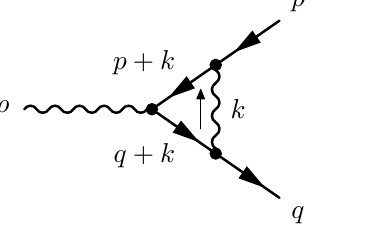
Figure 3 – Vertex correction diagram Рис. 3 − Диаграмма коррекции вершин Слика 3 – Дијаграм корекције